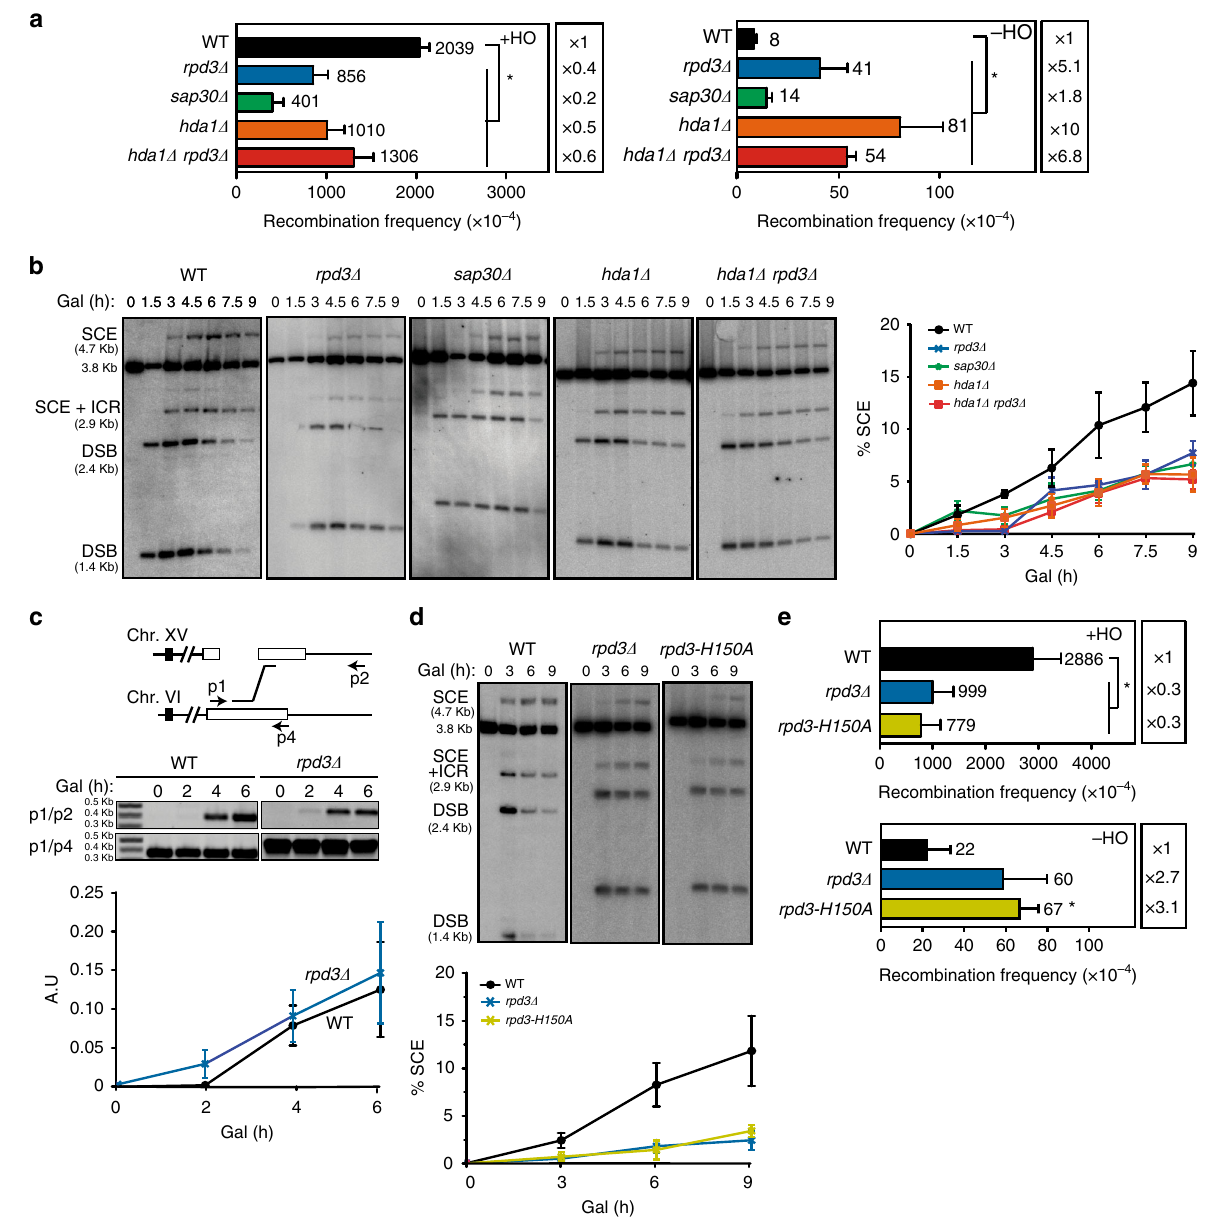
Fig. 3 Deacetylation by Hda1 and Rpd3L impacts SCE through the same pathway. a Analysis of spontaneous ( − HO) and HO-induced ( + HO) recombination frequencies in wild type (WSR-7D), rpd3 Δ (WSRPD3), sap30 Δ (WSSAP30), hda1 Δ (WSHDA1), and hda1 Δ rpd3 Δ (WSH1R3) strains transformed with pRS316-TINV ( n ≥ 3). b Representative Southern blots and quanti fi cation of the 4.7-kb SCE fragments during time-course experiments after HO induction performed in wild type (WSR-7D), rpd3 Δ (WSRPD3), sap30 Δ (WSSAP30), hda1 Δ (WSHDA1), and hda1 Δ rpd3 Δ (WSH1R3) strains transformed with pRS316-TINV ( n ≥ 3). c Quanti fi cation of BIR intermediates in wild type (JFR-4) and rpd3 Δ (JFRPD3) strains. A scheme of the BIR reaction is shown with the primers depicted as arrows. PCR with p1 and p2 oligos were used for the detection of BIR intermediates produced when the HO-cut chromosome III invades the homologous ACT1 intron sequence on chromosome VI. PCR with p1 and p4 primers was used as a control. A representative image of the PCR products is shown ( n = 4). d Representative Southern blots and quanti fi cation of the 4.7-kb SCE fragments during a time-course experiment after HO induction performed in the WSRPD3 ( rpd3 Δ ) strain transformed with YEplac112-Rpd3 (WT), YEplac112 ( rpd3 Δ ), or YEplac112-H150A ( rpd3-H150A ) plasmids ( n ≥ 3). e Analysis of spontaneous ( − HO) and HO-induced ( + HO) recombination frequencies in the WSRPD3 ( rpd3 Δ ) strain transformed with either YEplac112-Rpd3 (WT), YEplac112 ( rpd3 Δ ), or YEplac112-H150A ( rpd3-H150A ) and the pRS316-TINV plasmids ( n ≥ 4). Means and SEM are plotted in all panels. * p ≤ 0.05 (two-tailed Student ’ s t- test). In a and d , the 4.7-kb band is speci fi c for SCE whereas the 2.9-kb band can result from SCE and other inter-chromatid recombination (ICR) events. The 3.8-kb band corresponds to the intact plasmid and 1.4 and 2.4-kb bands to the DSBs. See also Supplementary Fig. 2. Data underlying this fi gure are provided as Source Data fi